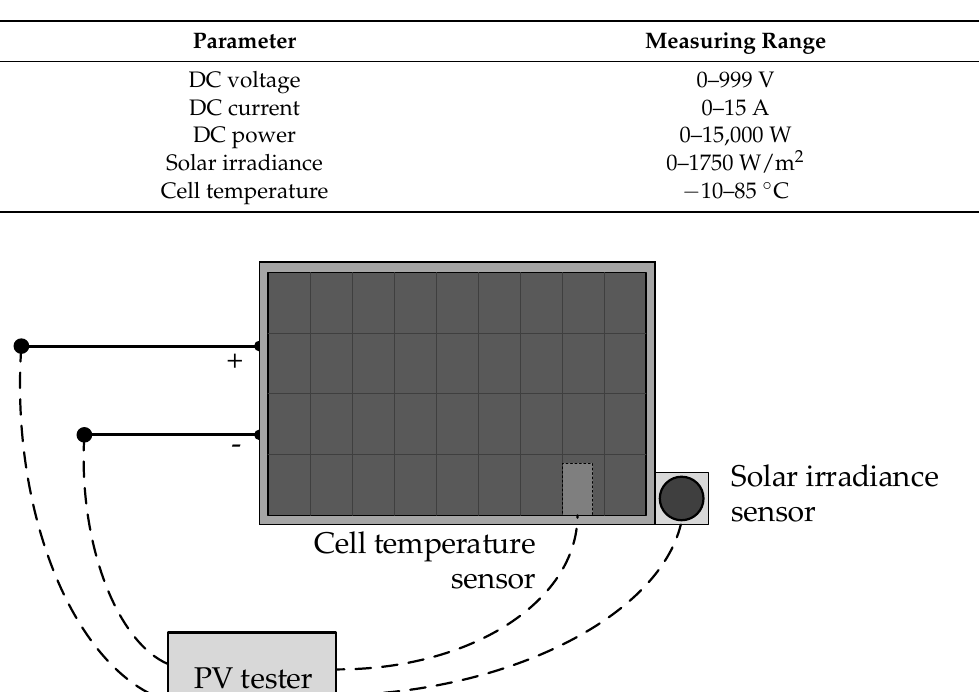
Table 8. PV tester I-V curve measurement module technical characteristics.